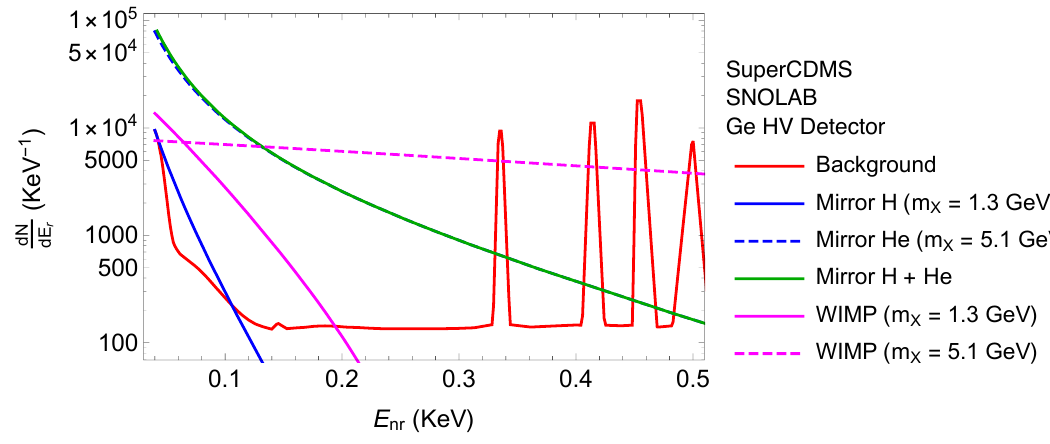
Figure 6 . Recoil spectrum in the SuperCDMS SNOLAB Ge HV detector assuming ionized halo DM distribution. For mirror H and He, assume local values r (cid:15) = 3 × 10 − 10 . We compare to a WIMP with m X = 1 . 3 (5 . 1) GeV and σ nX = 0 . 6 (1 . 1) × 10 − 42 cm − 2